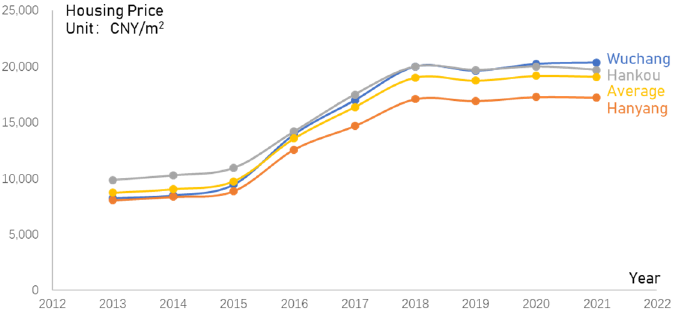
Figure 2. Housing price of Wuhan from 2013 to 2021 (MUA). Data source: https://www.anjuke.com/ (accessed on 1 January 2022).